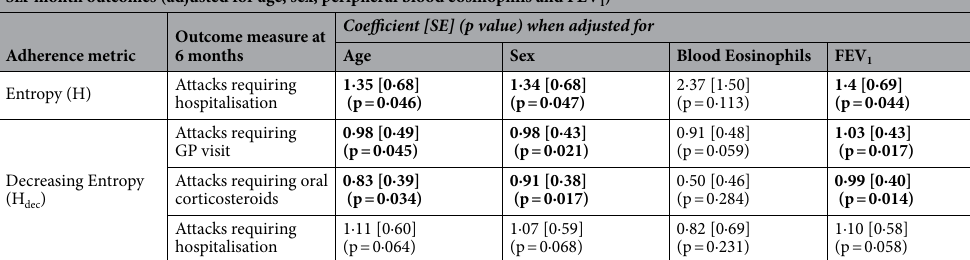
Table 3. Multivariable analysis relating adherence metrics to 6 month outcomes. GP general practitioner. Adherence metrics and outcome measures reported here are those which showed significant associations in univariate